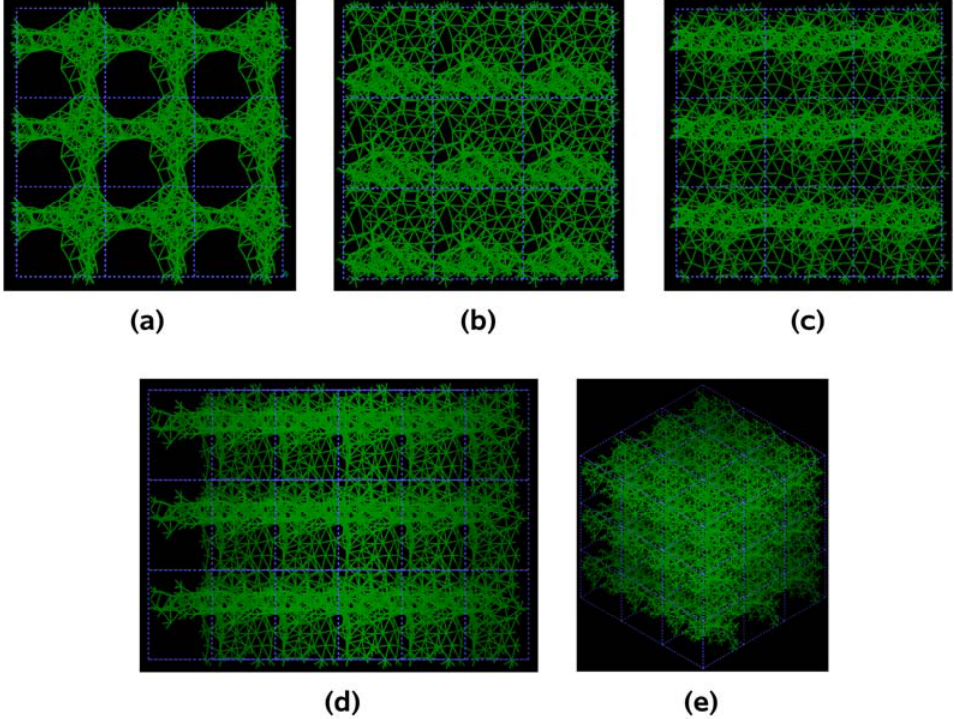
Figure 26. Pores formed in a 3 × 3 × 3 50% porosity, 108-gold atom supercell at the end of 500 MD steps at 1,320 K. Prominent through pores appear along the (a) x direction, and a tendency to through pore formation along all the other